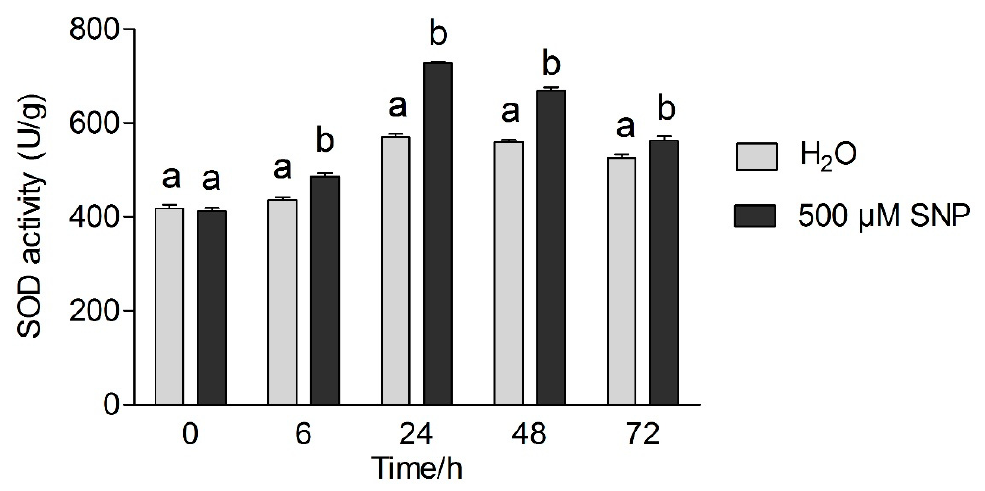
Figure 7. Effect of exogenous nitric oxide on superoxide dismutase (SOD) activity in tea leaves under cold stress.